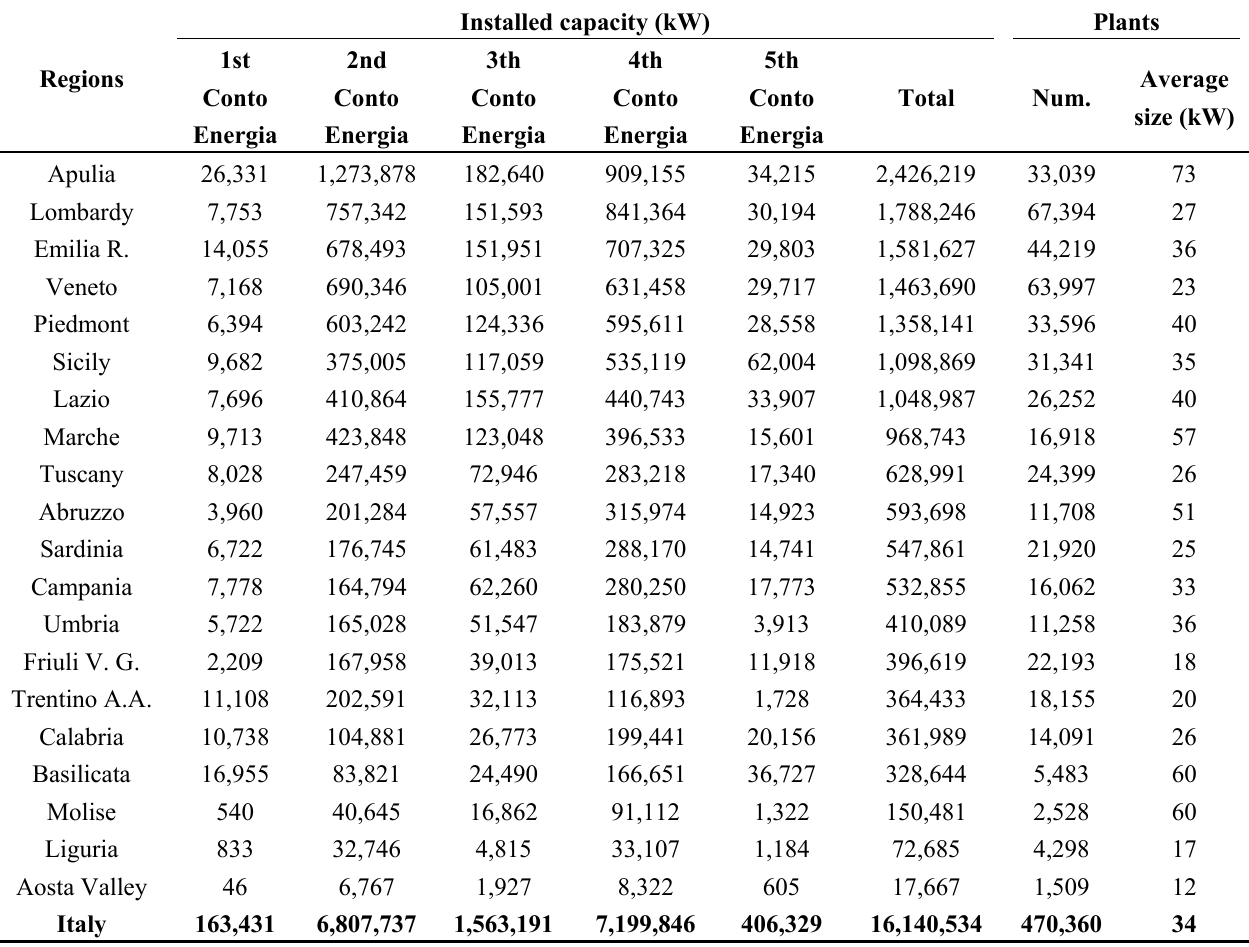
Table 1. Evolution of Italian PV